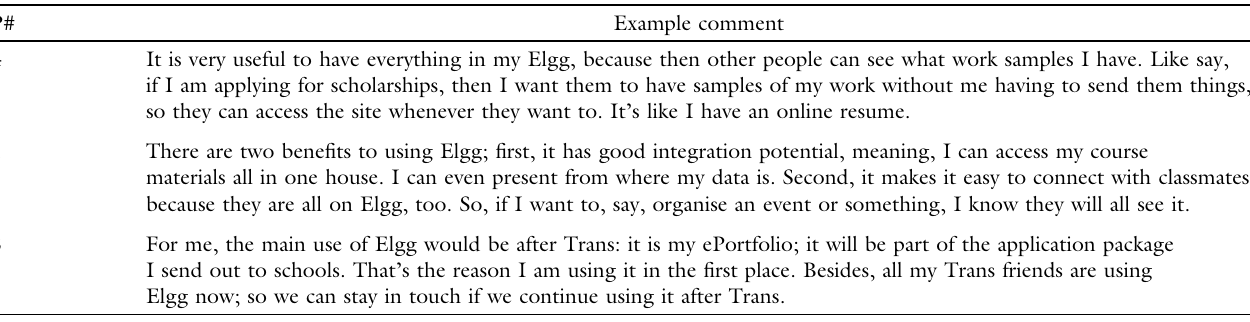
Table 1. Sample user quotes on the benefits of Elgg and tendency for long-term use.